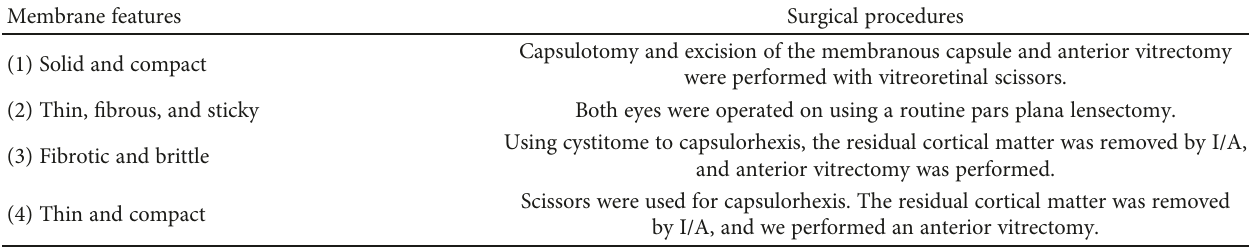
Table 1: Di ff erent surgical methods for congenital membrane